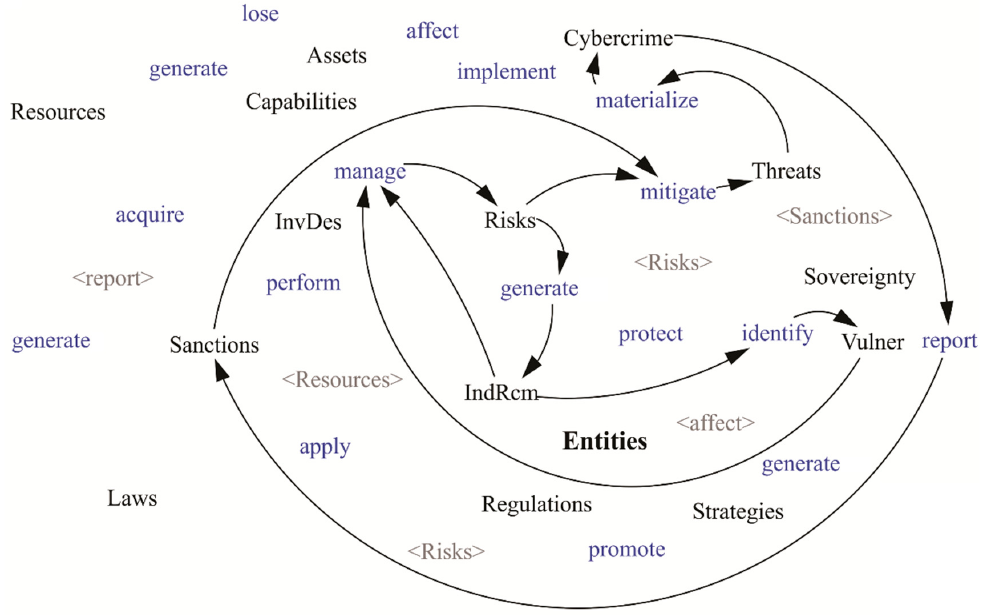
Figure 7. Cycle of crimes by sanctions and vulnerabilities.